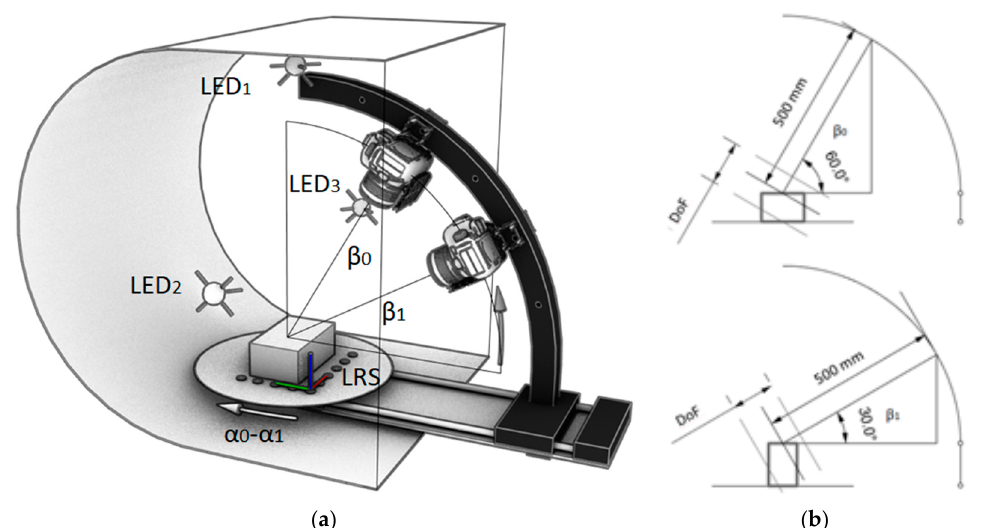
Figure 3. ( a ) Schematic representation of the photogrammetric rig used in this investigation; ( b ) example of the DoF (12.4 mm) calculated for f/22 aperture, used for the largest find (S1).